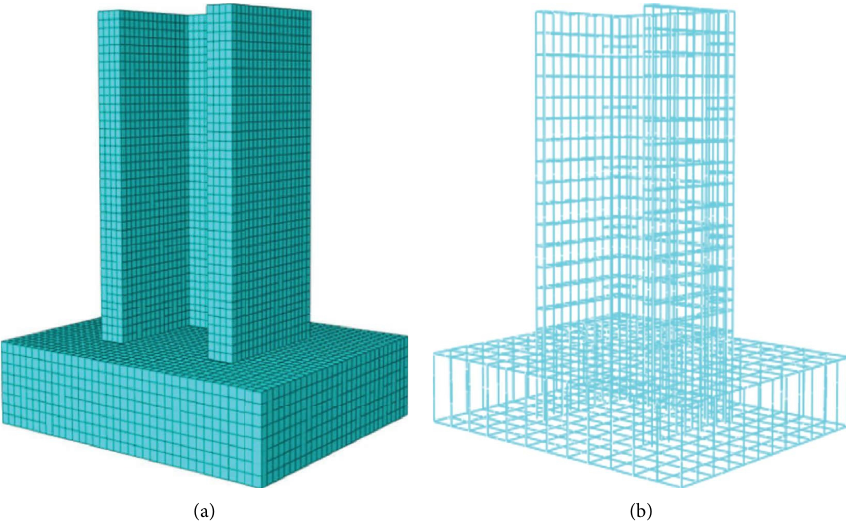
Figure 21: Finite element model. (a) Concrete. (b) Reinforced steel